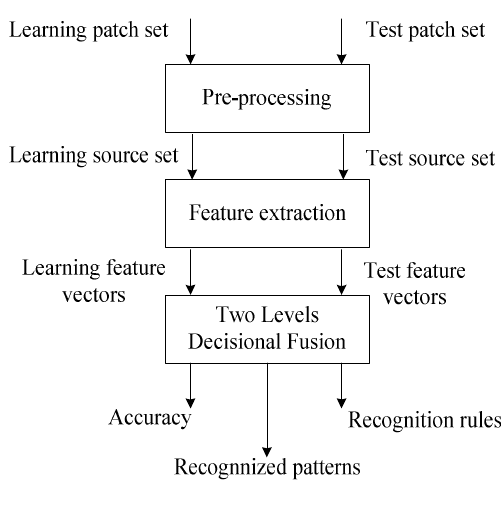
Figure 1. General approach